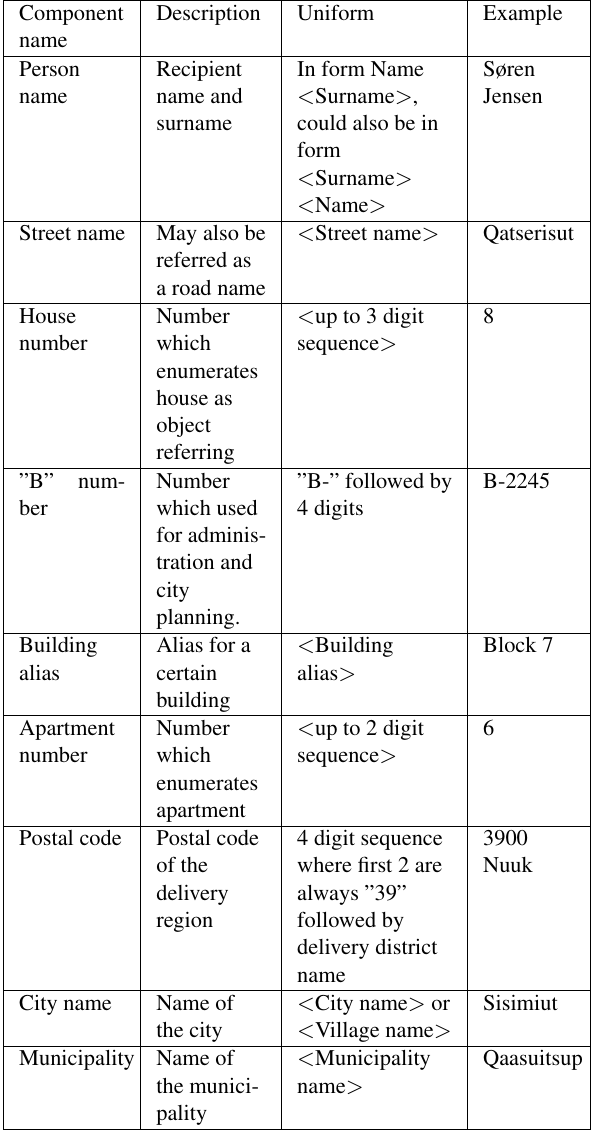
Table 1: Data dictionary of proposed Greenland addressing sys-